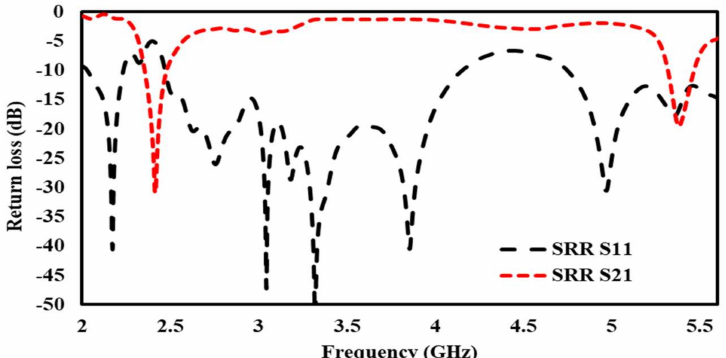
Figure 7. Simulated S11, S21 of 5 × 5 SRR array.